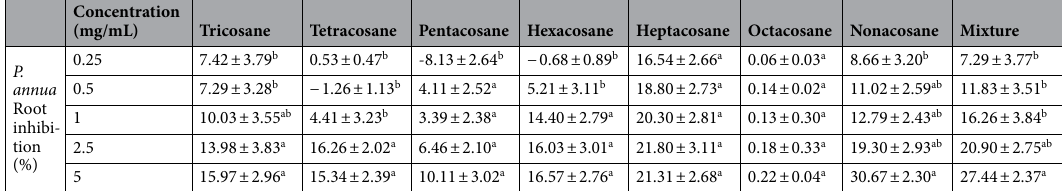
Table 4. Phytotoxic activity of alkanes on root growth of P. annua . a ± Standard error ( n = 30). b Different letters represent a significant difference at p < 0.05 level according to Fisher’s LSD test.